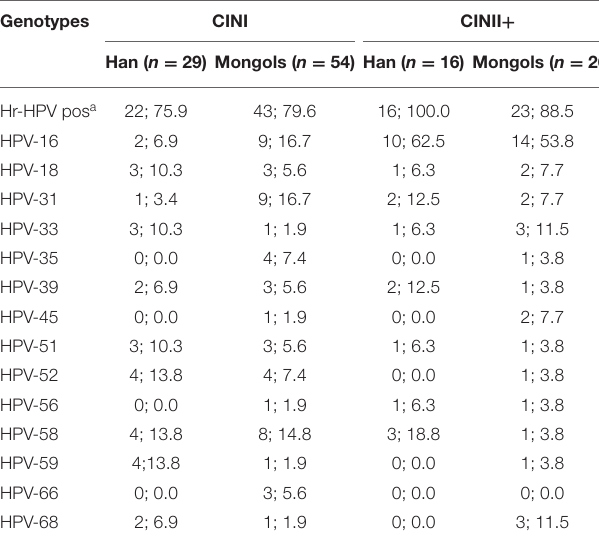
TABLE 2 | Prevalence of type-specific Hr-HPV infection in abnormal pathology diagnoses in Han and Mongols ( n ; %).